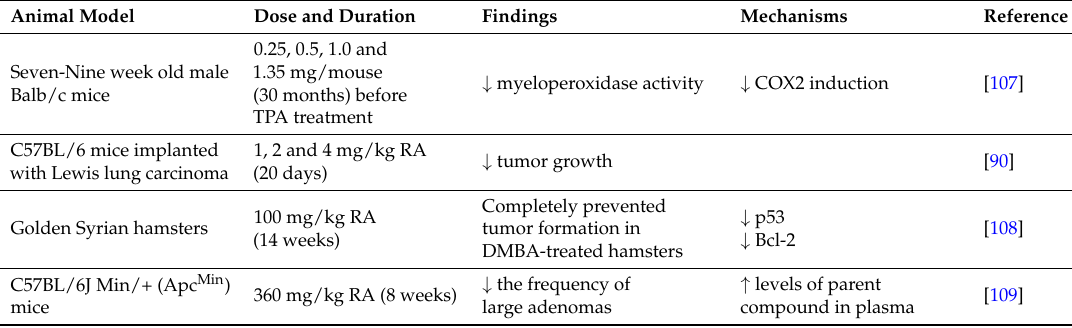
Table 16. Anticancer effects of Rosmarinic Acid (RA). In vivo